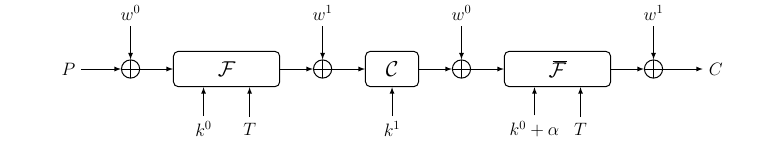
Figure 1: The Overall Scheme